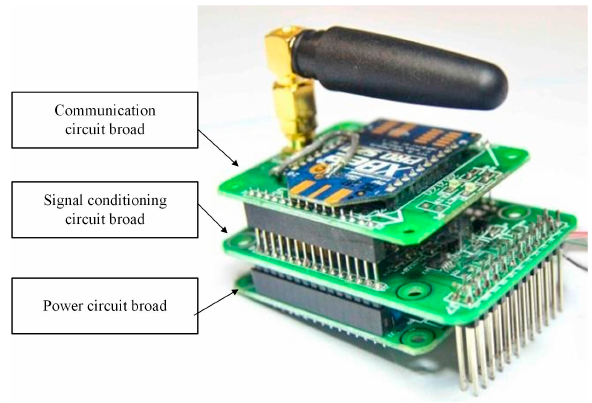
Figure 3. Photograph of the data acquisition node [18].